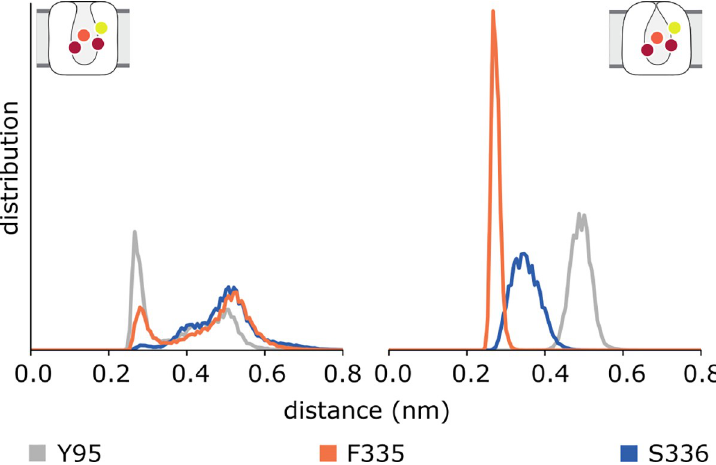
Fig 8. Interactions between the protonated nitrogen of 5HT and hSERT during molecular dynamics simulations. Aside from the salt-bridge with the deprotonated side chain of D98 (not shown), the amine coordinates the backbone oxygen atoms of Y95 (gray), F335 (orange), and S336 (blue). In the outward-open state (left), these distances increase over time, whereas they form a stable network in the outward-occluded state (right). Data are shown as normalized distributions over the combined simulation time.